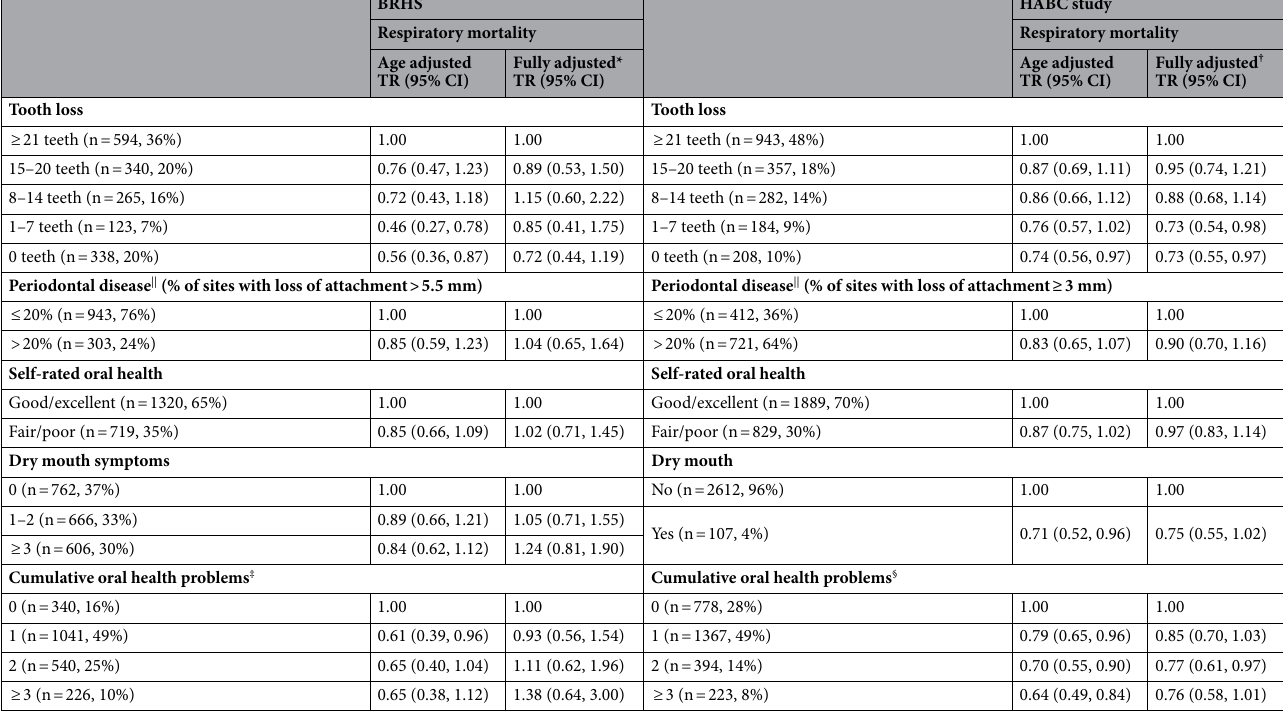
Table 4. Accelerated failure time analysis (time ratios (TR) and 95% confidence intervals (CI)) for the association between oral health problems and respiratory mortality in older people in the BRHS after 9 years of follow-up and the HABC Study after 15 years of follow-up. *Age, social class, smoking, alcohol, physical activity, history of CVD and diabetes, BMI, EDI score, FEV1/FVC ratio, hypertension, triglycerides, HDL, CRP, IL-6, fibrin d-dimer, hsTnT. † Age, gender, race, education, smoking, alcohol, physical activity, history of CVD and diabetes, BMI, HEI score, respiration rate, hypertension, total blood cholesterol, CRP, IL-6. ‡ Includes < 21 teeth, difficulty eating, symptoms of dry mouth, and sensitivity to hot/cold/sweet. § Includes < 21 teeth, difficulty eating, dry mouth when eating, and limit of food due to gum problems. || Only measures of periodontal disease with positive associations